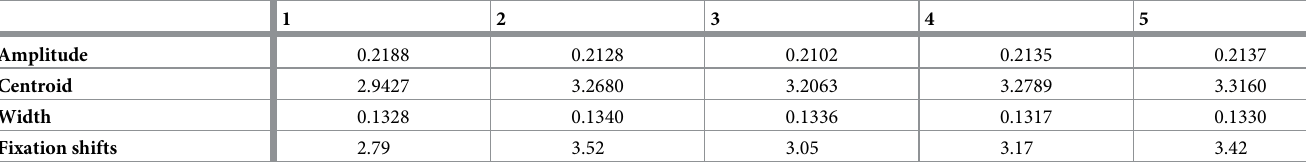
Conflict is defined from 1 (low conflict) to 5 (high conflict), with a probability of .5 of choosing the LL reward as maximum conflict. Amplitude has been normalised to MVC (maximal voluntary contraction). Centroid and width are reported in